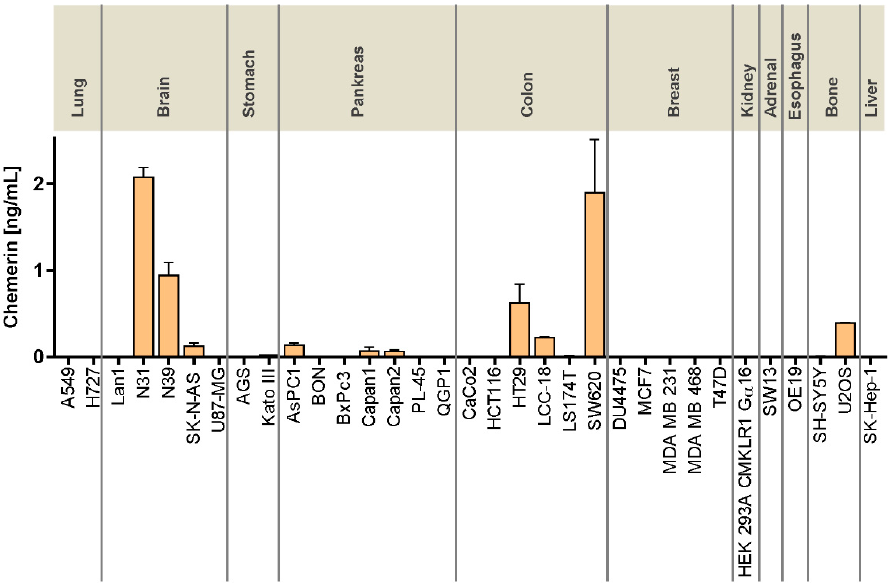
Figure 2. Secretion of the peptide chemerin by CRC and other cancer cell lines as determined by ELISA quantitation of cell culture supernatants. Cells had been cultured at a density of ~70%; supernatants were collected after 24 h of incubation. The upper section denotes the organ of tumor origin; cell line designations are provided at the bottom. All data represent mean ± SD of n = 2–6 independent experiments performed in duplicate.